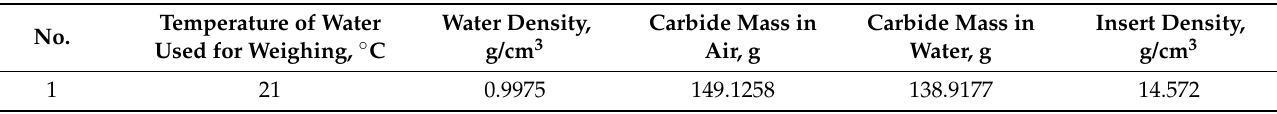
Based on Tables 5 and 6 and the standard [43]—carbide type